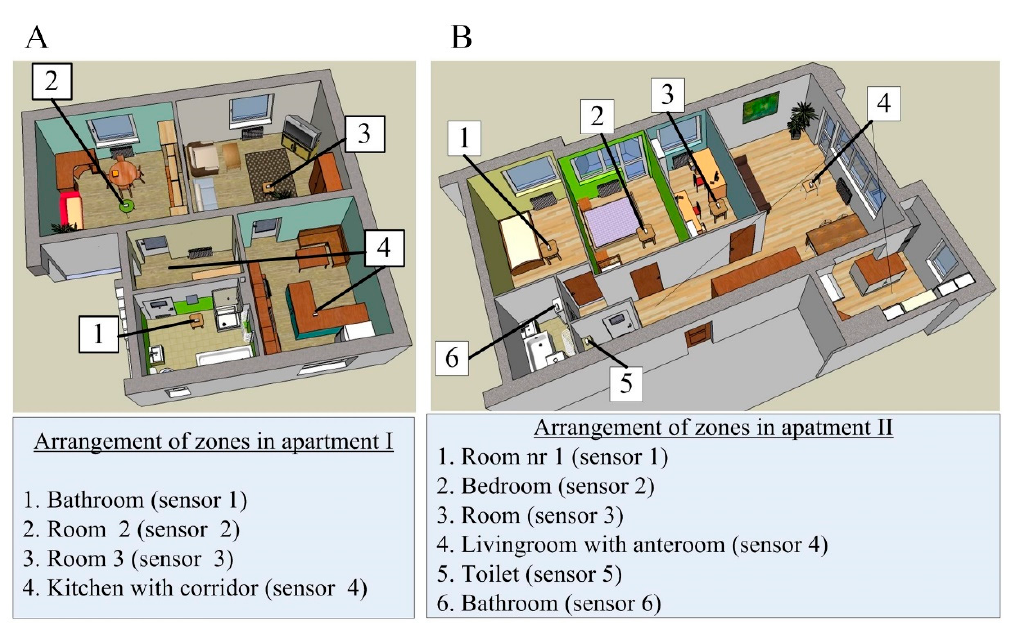
Figure 3. A plan view showing the arrangement of the zones; A – apartment I; B – apartment